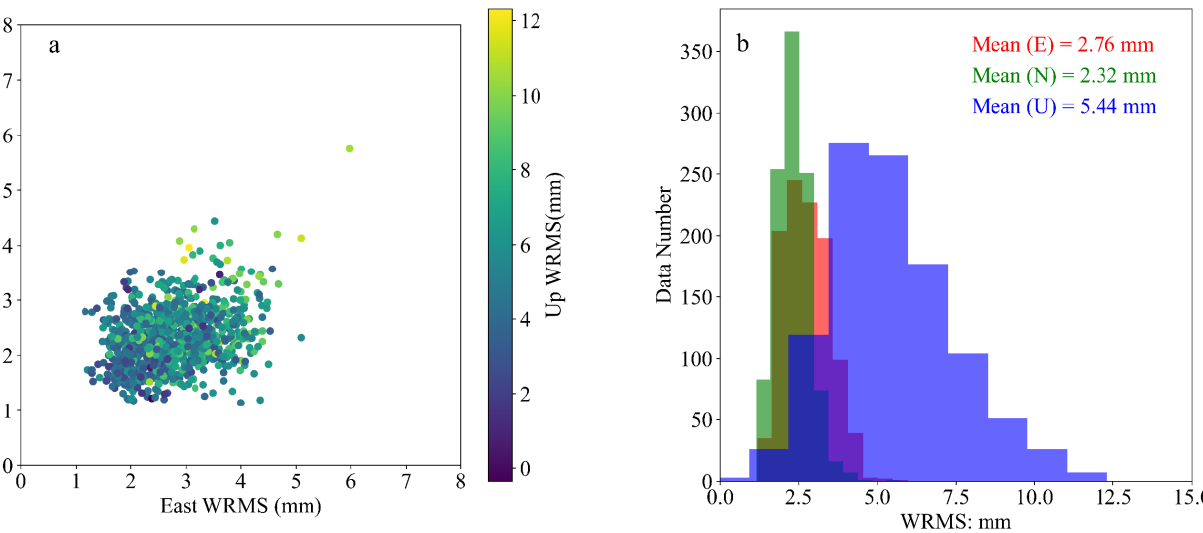
Figure 4. WRMS distributions for the time series of PGSs in the N, E, and U directions. ( a ) WRMS values for the U direction represented by gradient viridis colors. ( b ) WRMS distribution for N (green bars), E (red bars), and U (blue bars) directions.